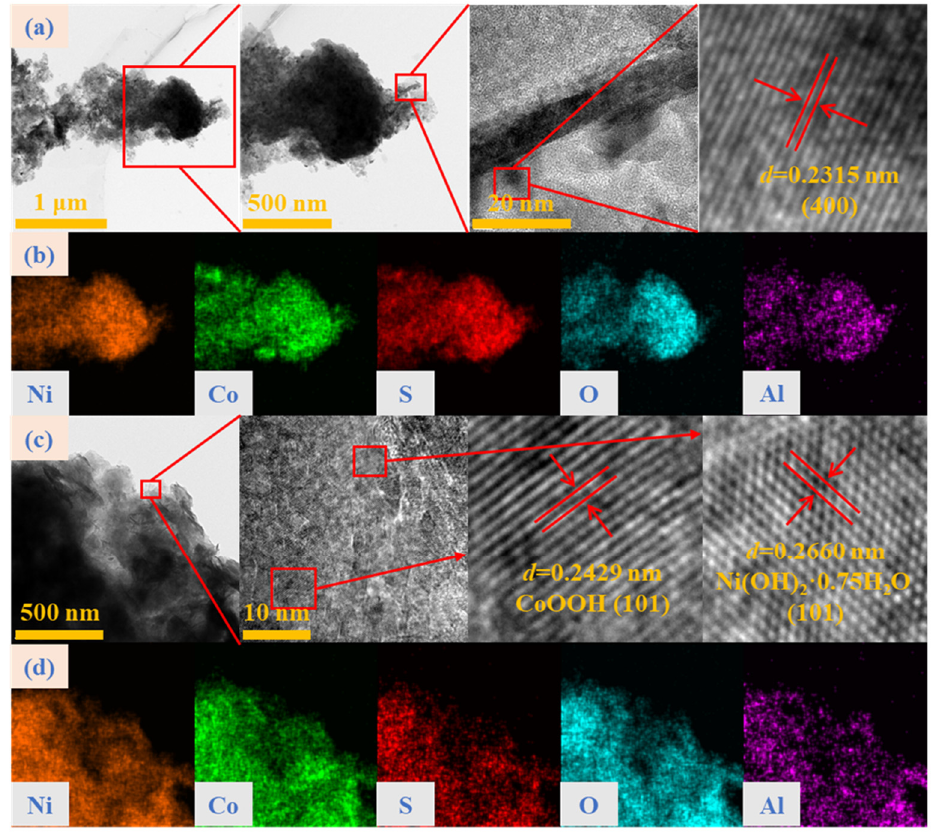
Figure 3. ( a ) The morphology and lattice fringe of Ni 2 Co 1 S 4 , ( b ) EDS mapping of Ni 2 Co 1 S 4 , ( c ) the morphology and lattice fringe of Ni 2 Co 1 S 4 -E, ( d ) EDS mapping of Ni 2 Co 1 S 4 -E.